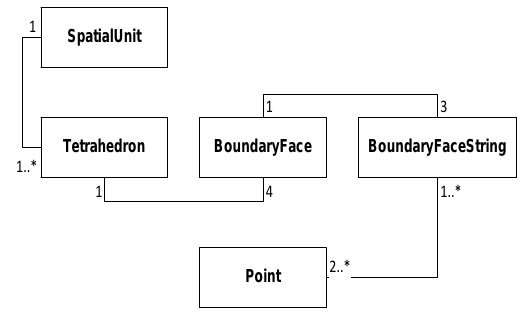
Figure 2. Conceptual model of TEN data structure based on LADM